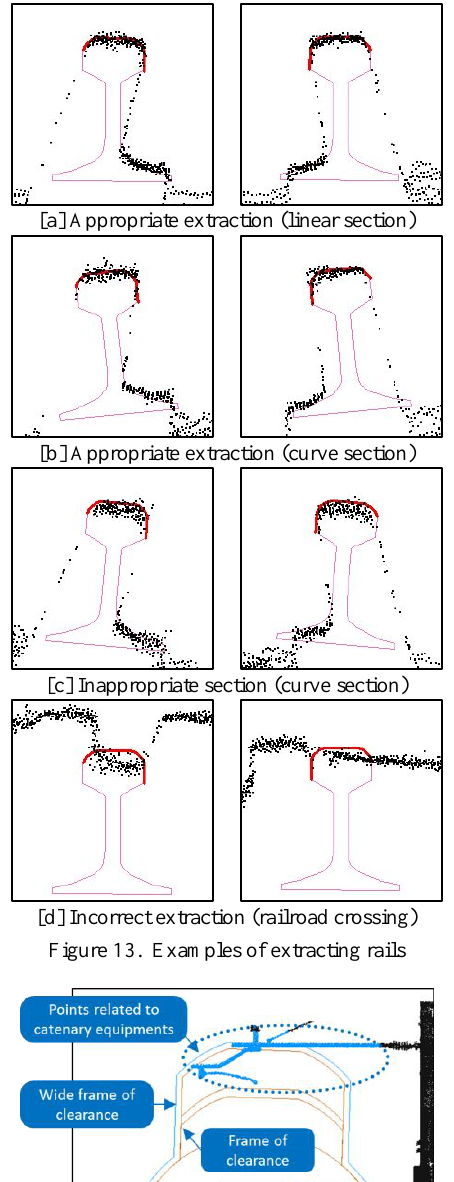
Figure 14. An example of extracting points inside the clearance and points related to catenary equipments